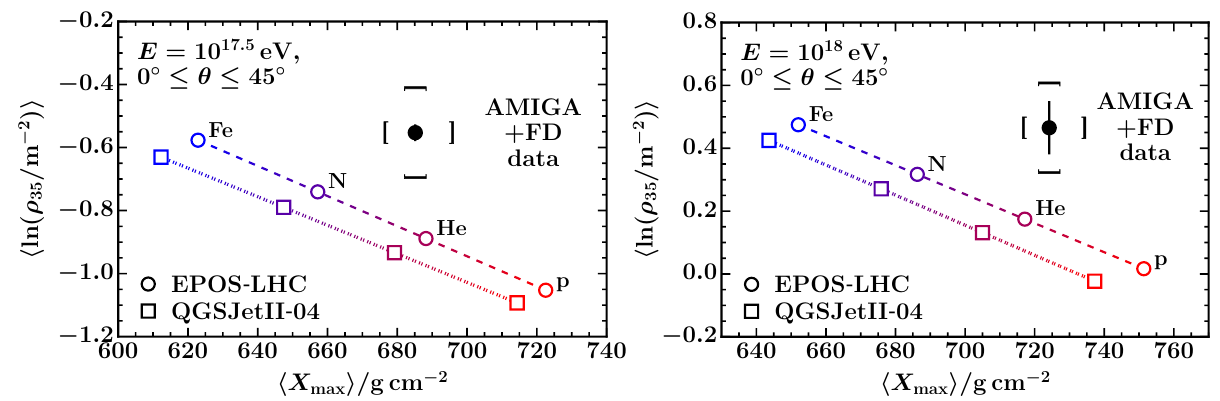
Figure 10: Comparison of the muon content in data and simulations with independent measurements of the mean depth of shower maximum (cid:104) X max (cid:105) by the FD and the mean logarithmic muon density (cid:104) ln ρ 35 (cid:105) by AMIGA at primary energies of 10 17 . 5 eV ( left ) and 10 18 eV ( right ). The expected muon densities from simulations are shown as a function of (cid:104) X max (cid:105) , corresponding to di ff erent mean logarithmic masses, for the EPOS-LHC and QGSJ et II-04 hadronic interaction models.